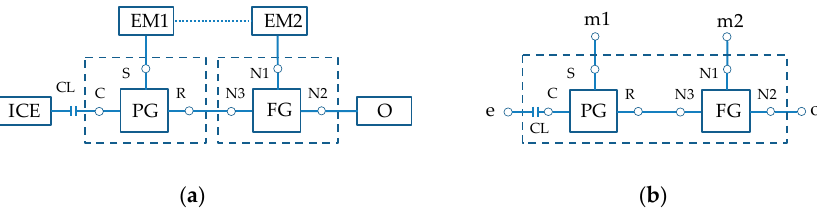
Figure 19. Type-b architecture: ( a ) FHS; ( b ) four-port diagram.